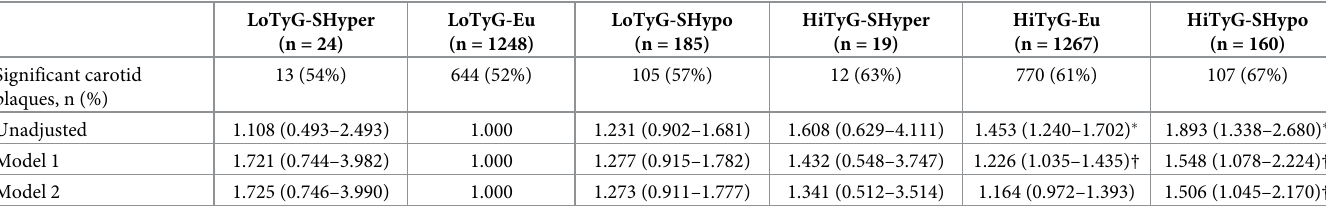
Table 4. Odds ratio (OR) and 95% confidence intervals (CI) for risk of significant carotid plaques based on the triglyceride-glucose index and thyroid function status.